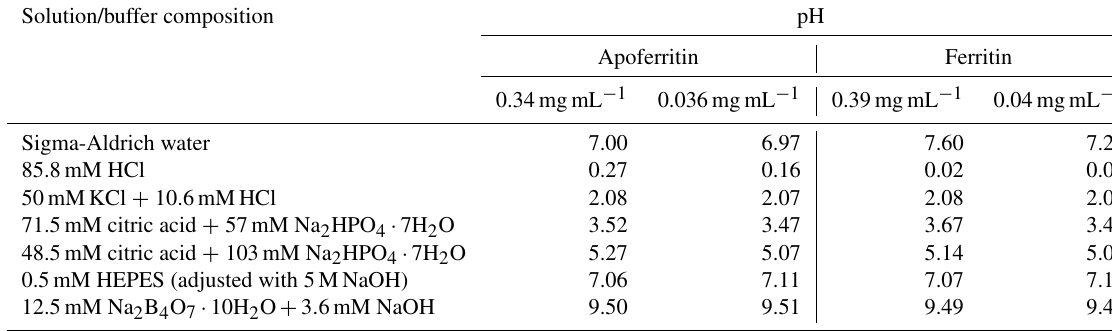
Table 1. pH values of the apoferritin and ferritin solutions in water and the buffered samples. Solution/buffer